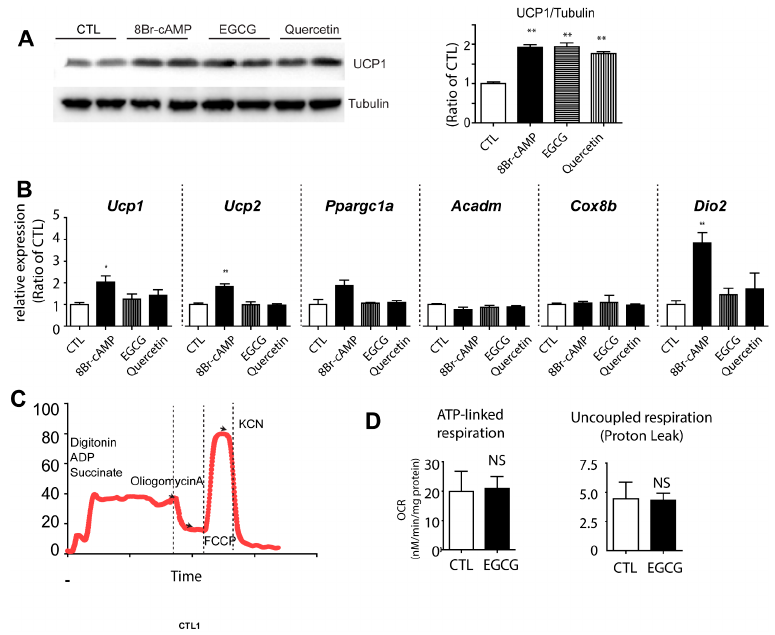
Figure 2. Effects of EGCG on brown adipocyte marker expression in adipocyte cultures. Immunoblot analysis of UCP1 expression ( A ) and quantitative PCR analysis ( B ) of genes involved in mitochondrial metabolism and brown adipocyte markers in adipocytes differentiated from C 3 H 10 T1/2 treated with 8Br-cAMP (1 mM), EGCG (10 μ M) and quercetin (10 μ M) for 24 h ( C , D ) Analysis of oxygen consumption of adipocytes differentiated from C 3 H 10 T1/2 cells treated with EGCG for 24 h. ( C ) An example of analysis of oxygen consumption rate (OCR) with a series of treatments of indicated drugs. ( D ) Comparisons of ATP-linked respiration and uncoupled respiration between cells treated with EGCG and vehicle controls. p values were calculated using the two-tailed unpaired t -test ( n = 3, means ± SE; * p < 0.05, ** p < 0.01).